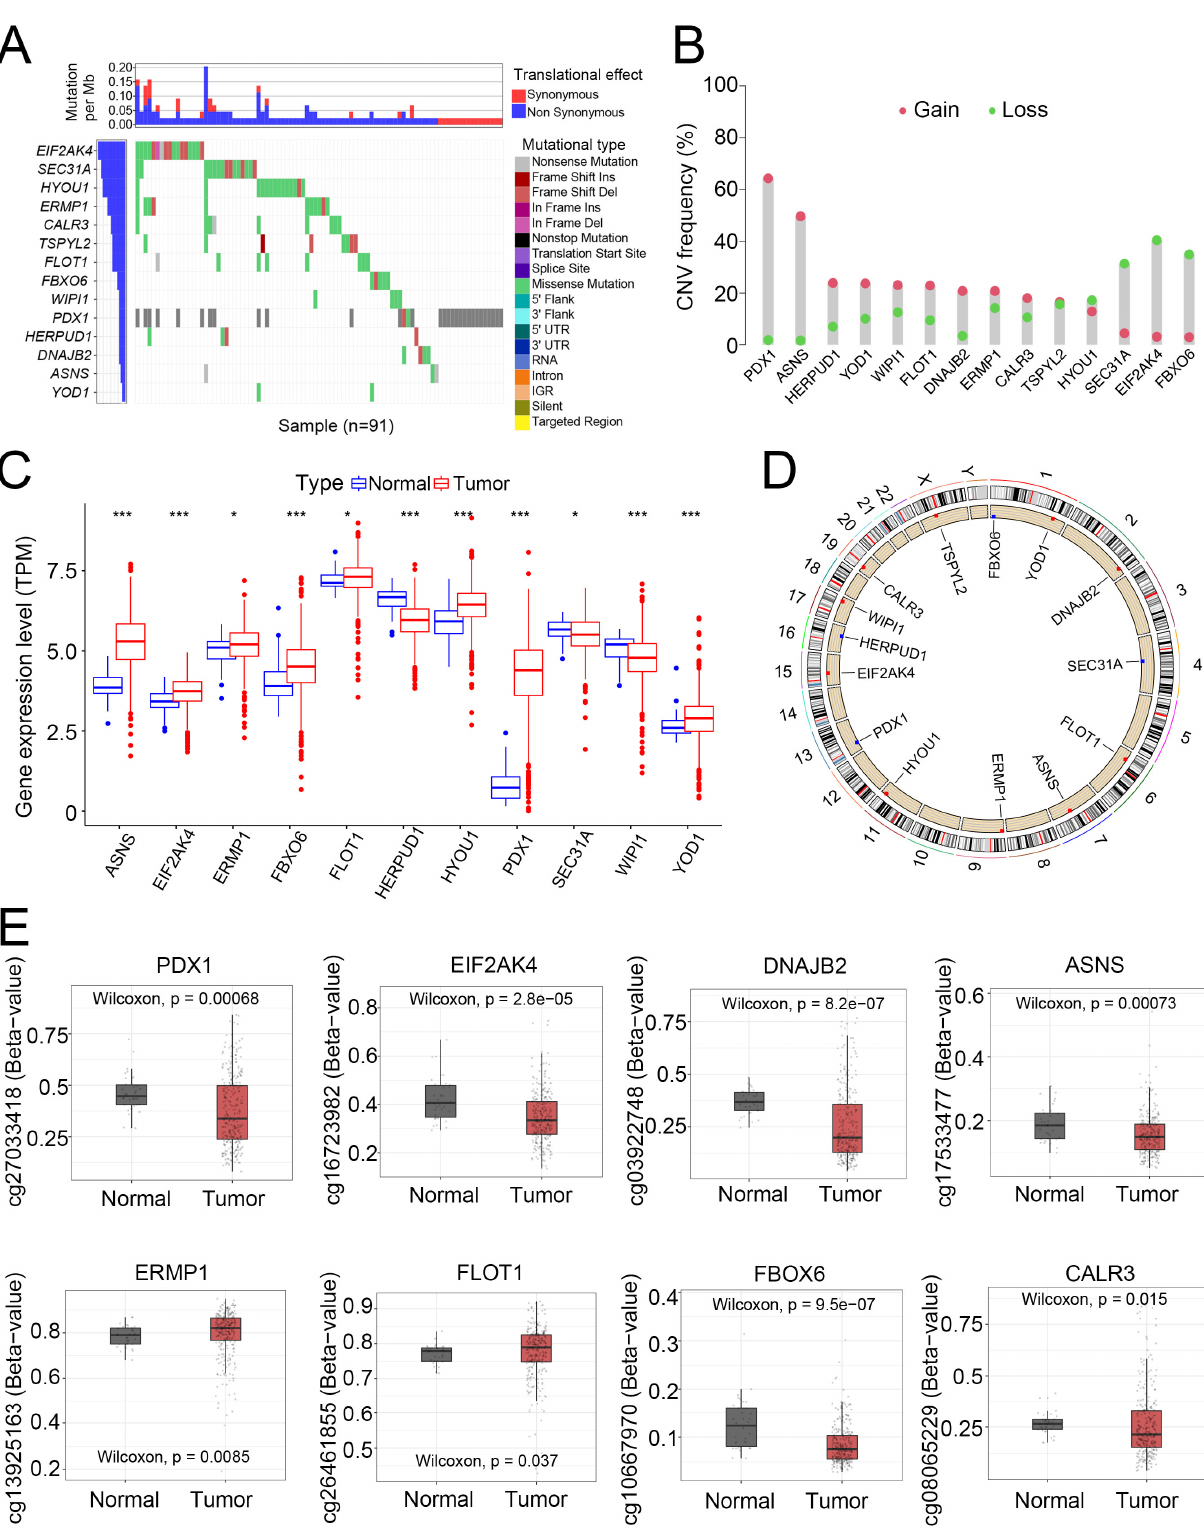
Figure 6. Mutational, transcriptional, and methylation alteration of the screened out 14 ER stress- related genes. ( A ) Mutational landscape of the 14 ER stress-related genes in 91 patients with CRC from TCGA database. ( B ) Frequencies of CNV gain and loss among the 14 genes. ( C ) DEGs among the 14 genes between CRC and normal adjacent tissue (* p < 0.05, *** p < 0.001). ( D ) Illustration of the locations of CNV gain and loss in the 14 ER stress-related genes. ( E ) Differentially methylated promoter sites among the 14